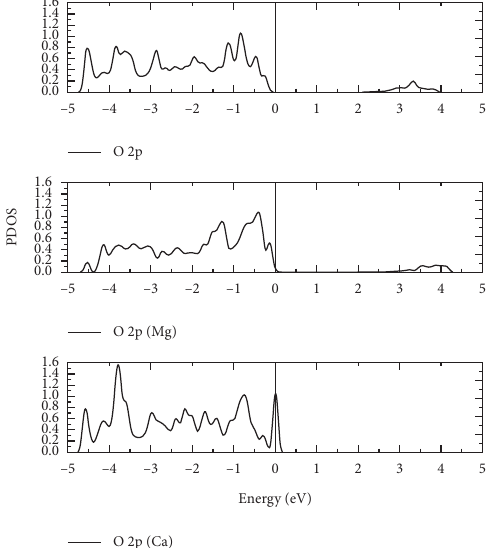
Figure 10: PDOS of O 2p states in